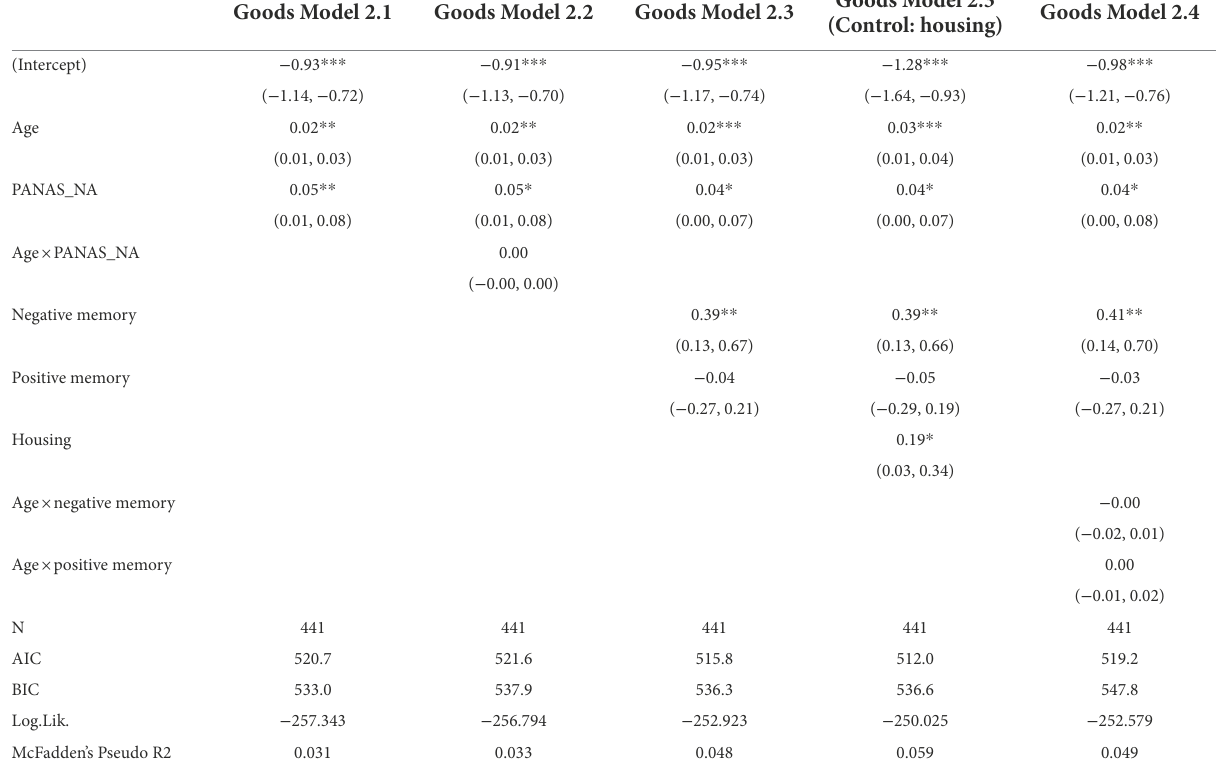
TABLE 5 Goods scarcity model (memory